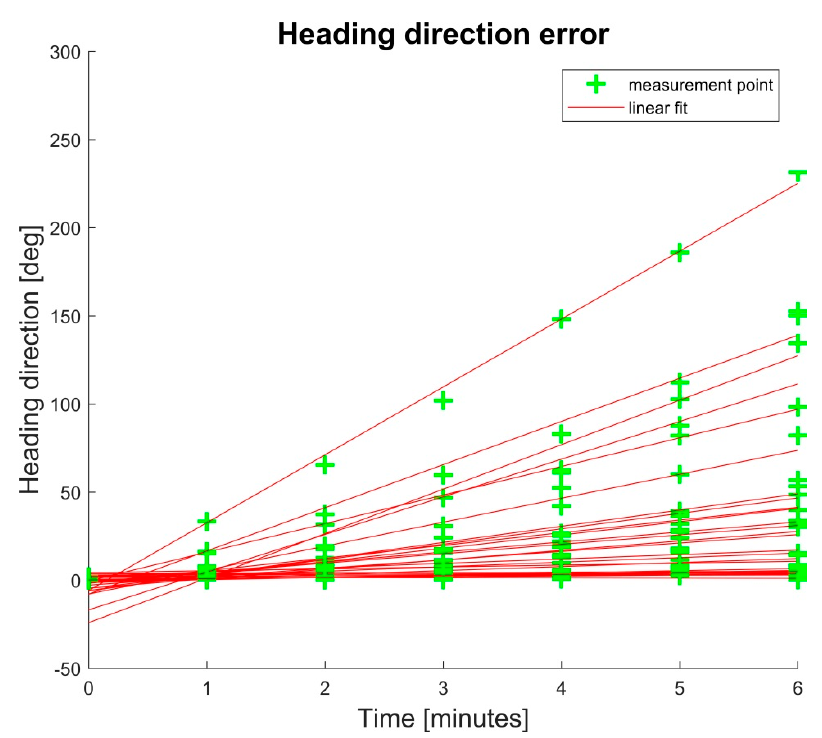
Figure 5. Error of the global pelvis rotation in the transversal plane at minute 0, 1, 2, 3, 4, 5, and 6 for all subjects. The drift in the global transversal plane showed a linear trend but no consistent dimension.